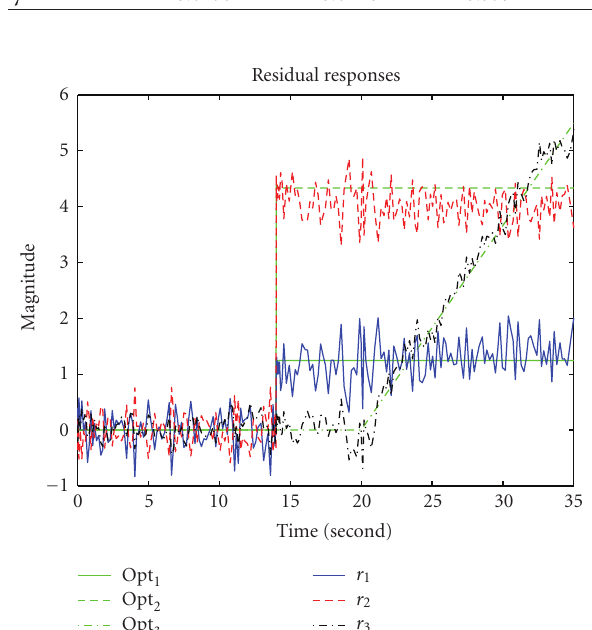
Figure 3: Time response of the residual after the optimization.